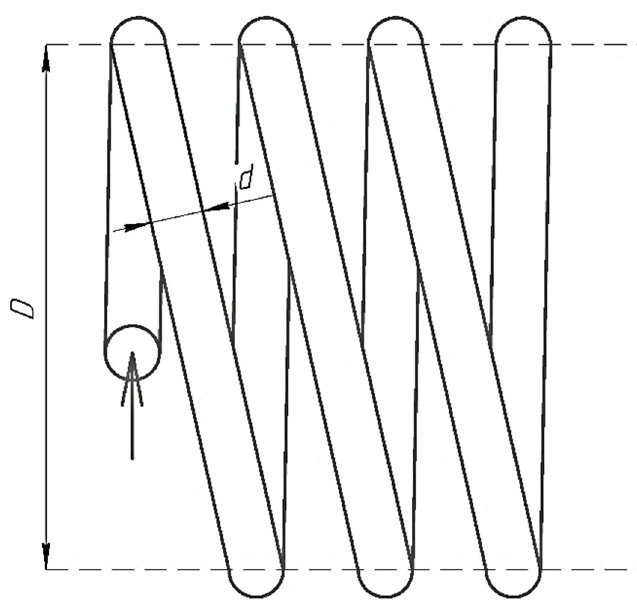
Figure 1. Coil Figure 1. Coil diagram.